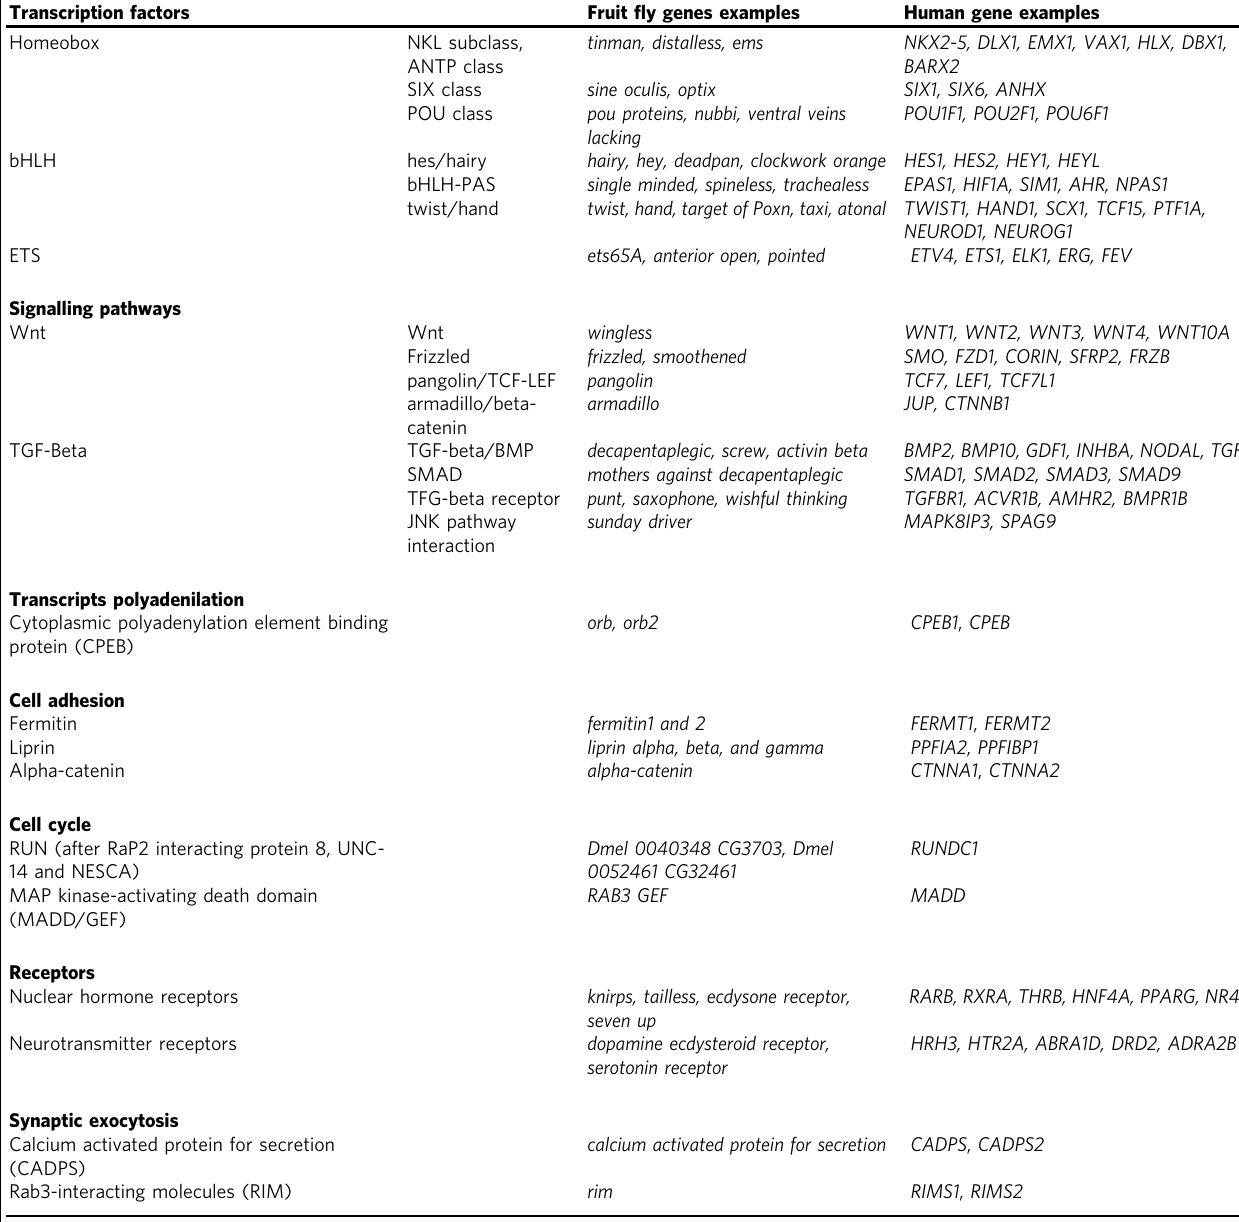
Table 1 Novel Core genes in the Animal Kingdom Transcription factors Fruit fl y genes examples Human gene